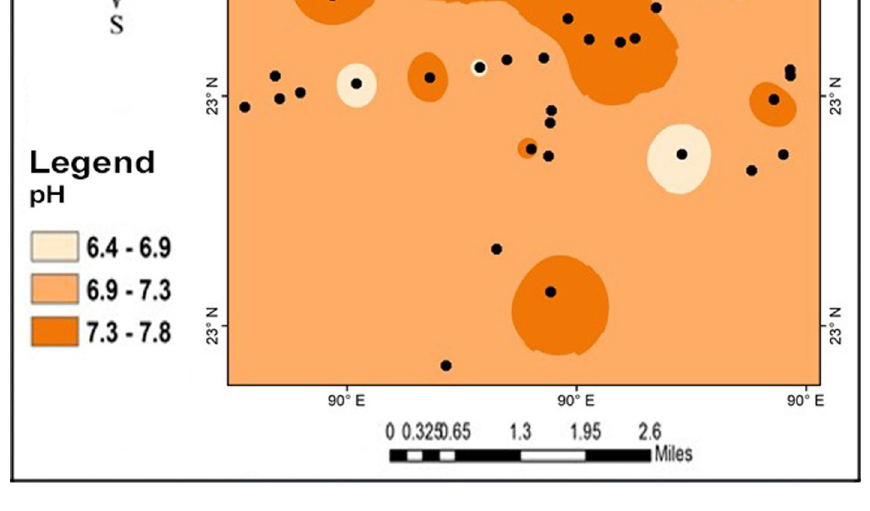
Fig. 4 Spatial distribution of EC in selected tube wells